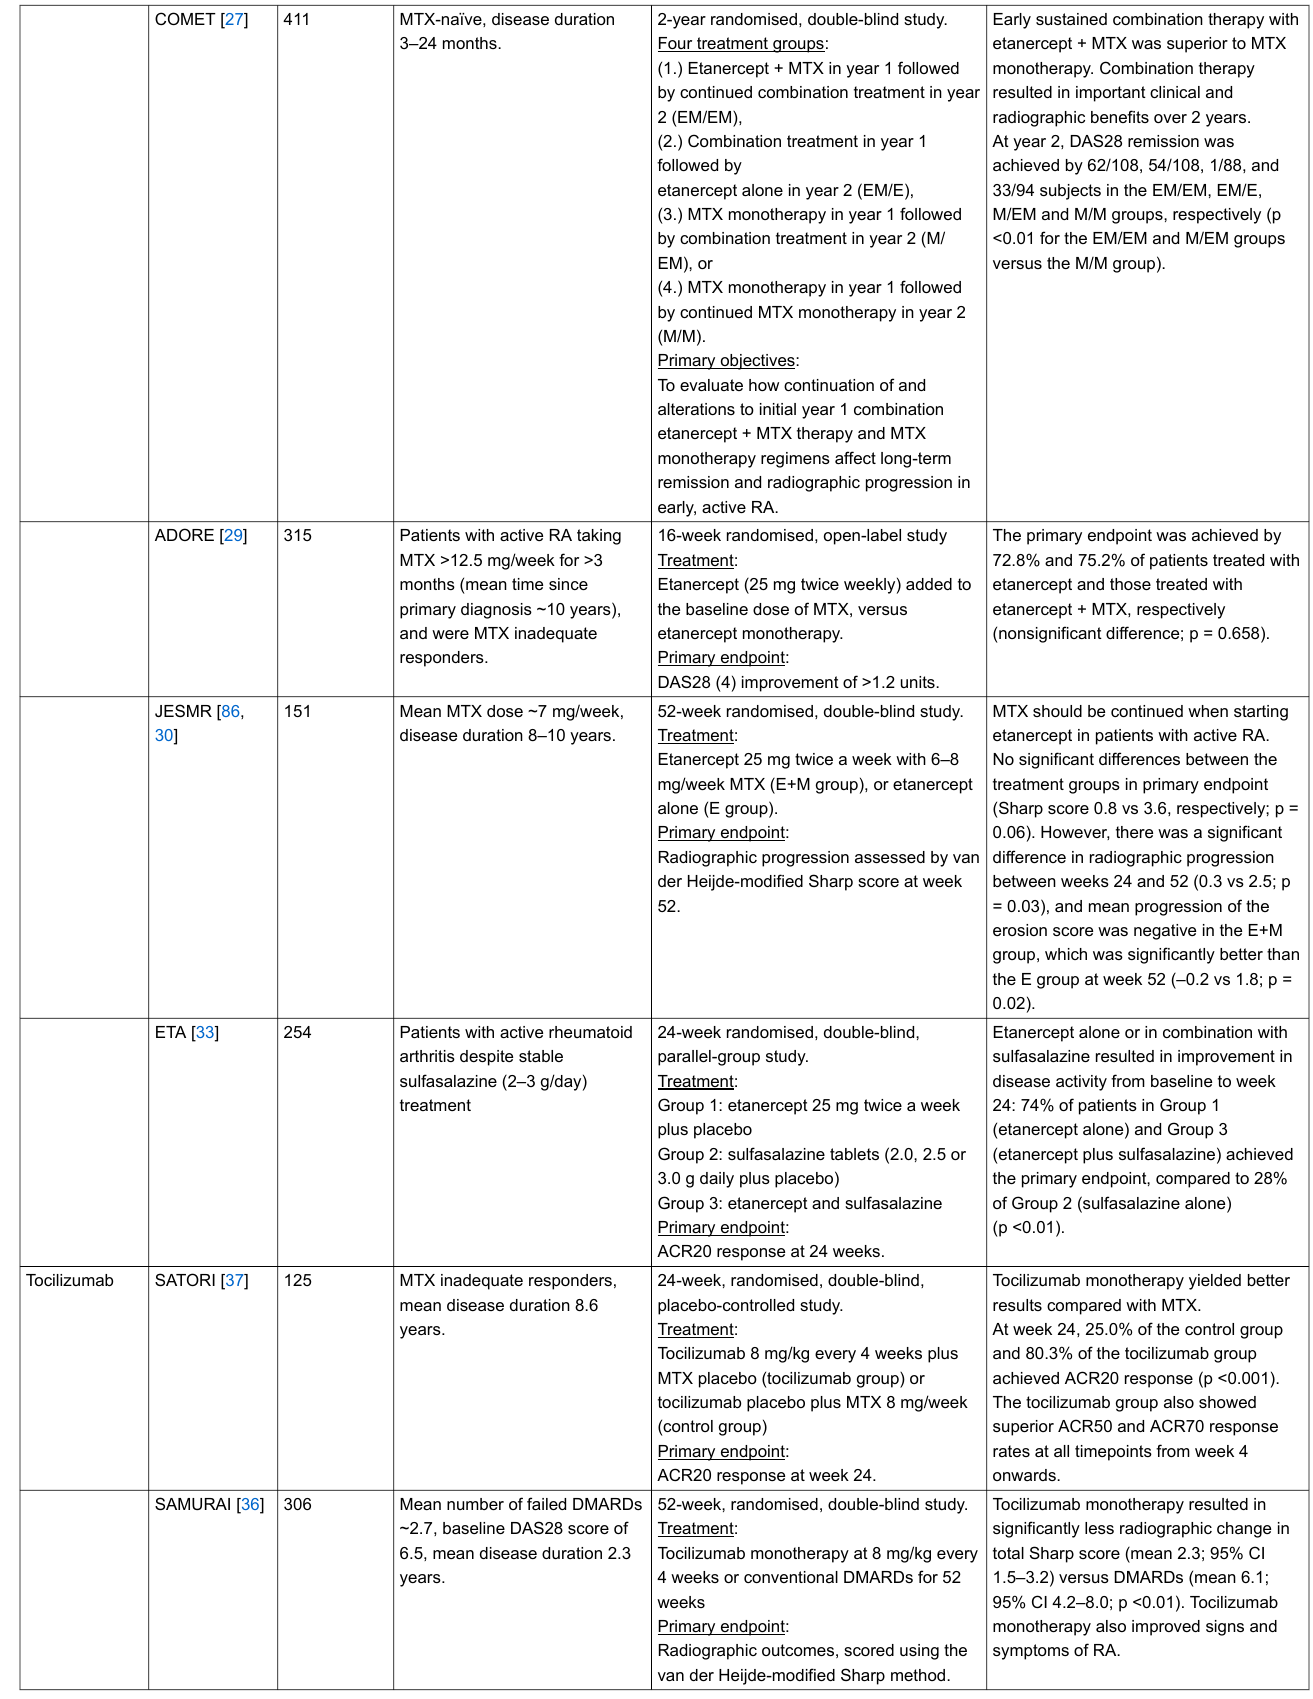
MTX-naïve, disease duration 3–24 months.